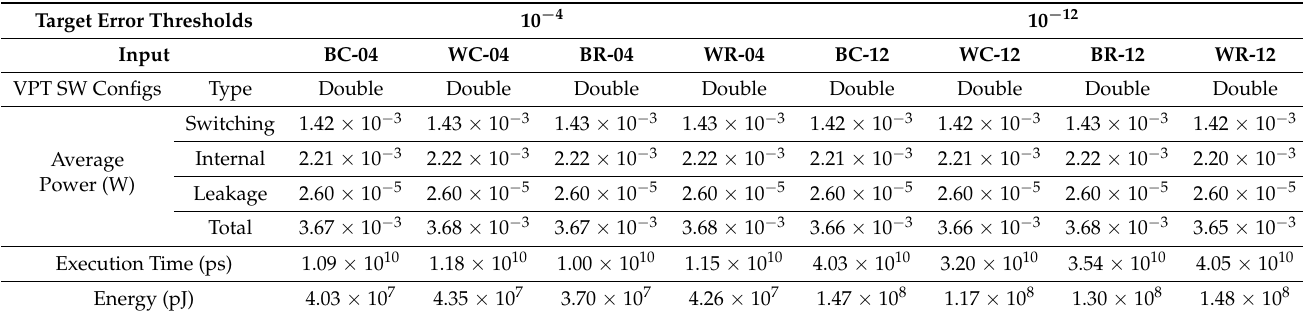
Table 3. Power, execution time, and energy consumption of the standard double precision version of Jacobi executed on the RV64FD reference